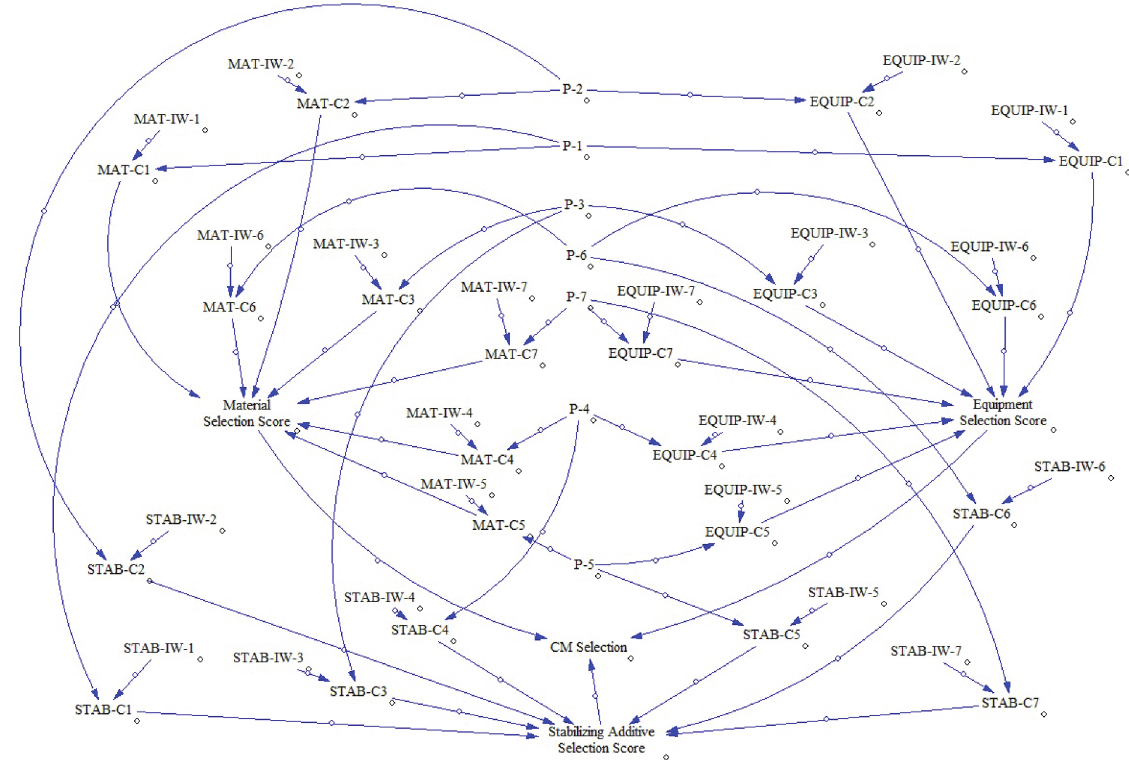
Fig. 4. Relations between project conditions and resource performance